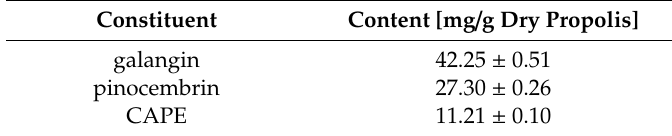
Table 2. Cytokines release by LPS-stimulated human PBMC. *** p < 0.001 vs. ctrl. Parameter